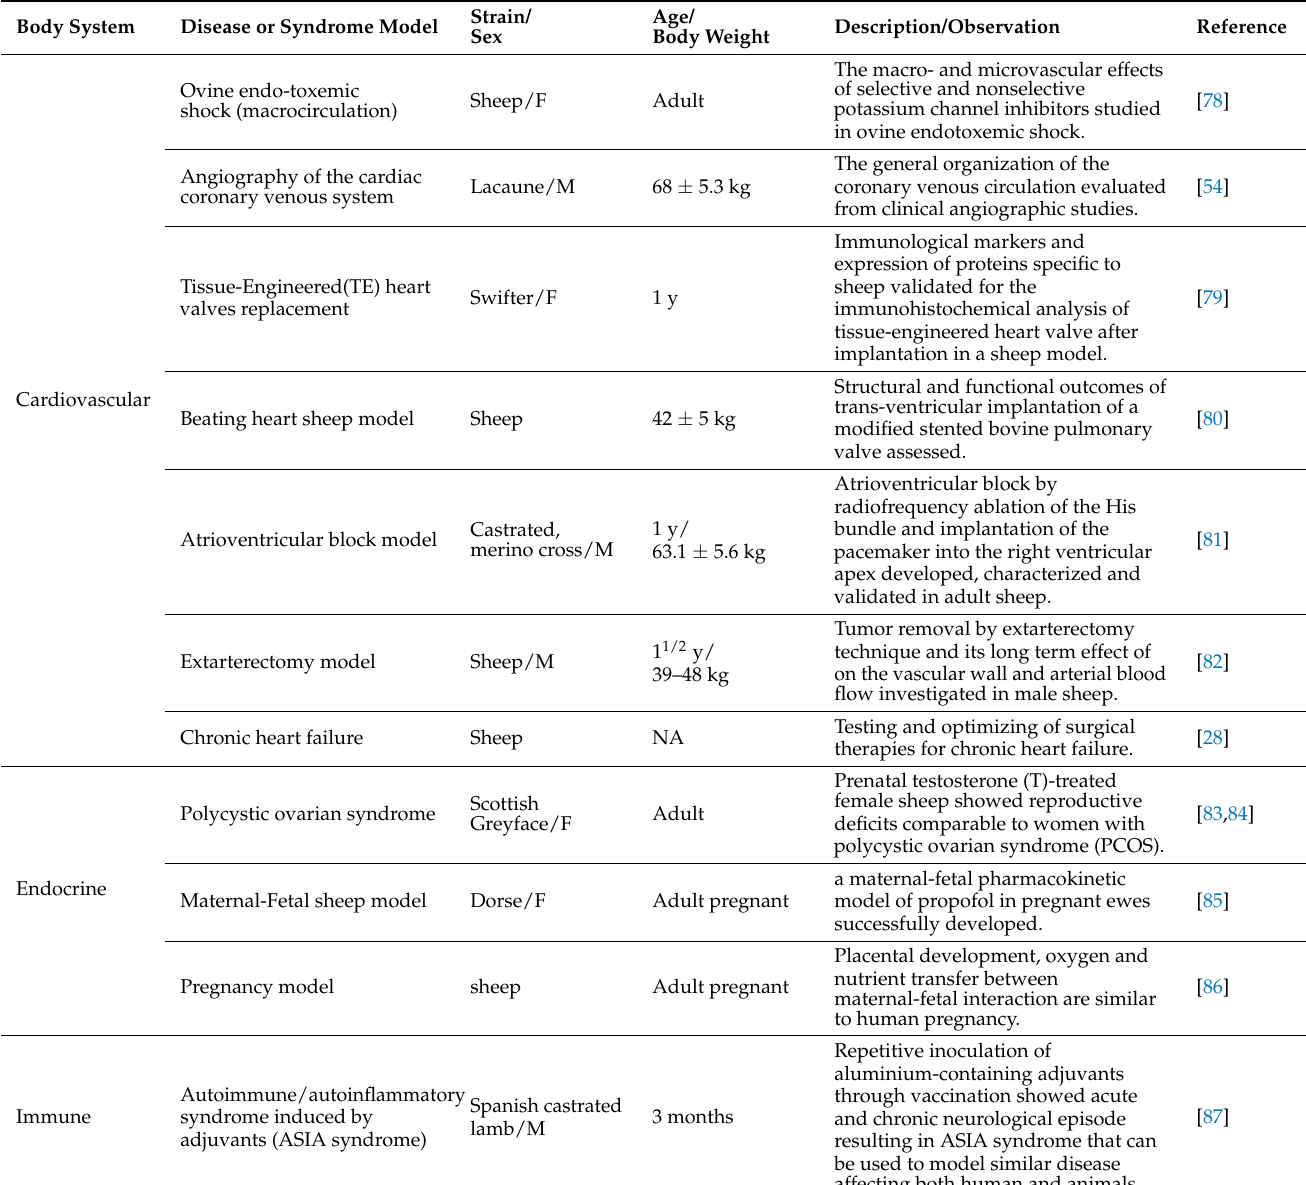
Table 4. Summary of the available sheep models of major physiological